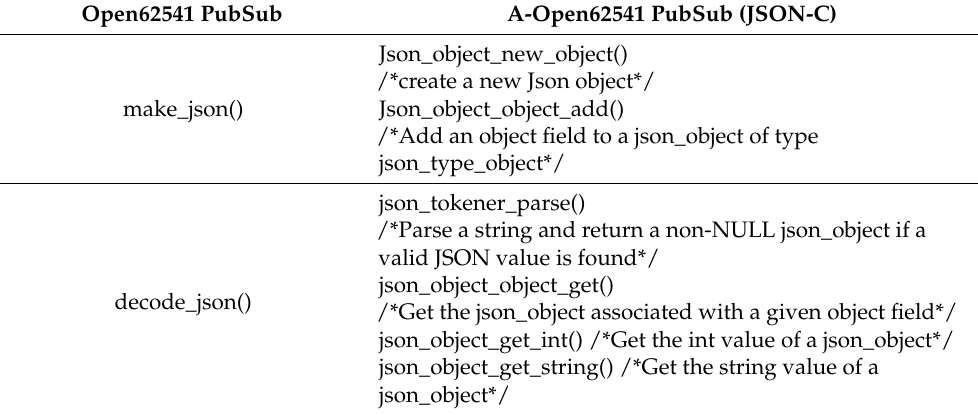
Table 3. A-Open62541 PubSub JSON-C API.